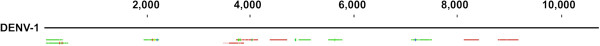
Read mapping against DENV-1 genome at 1X102.5 pfu/ml. Reads resulting from 1 454 Titanium sequencing run of a cDNA library made from blood spiked with DENV-1 at titer of 1X102.5 pfu/ml were aligned to the reference genome NC_001477.1 using CLC Genomics Workbench version 6.0.4 at default parameters.